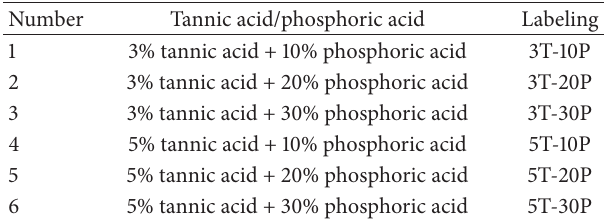
Table 1: The combinations of tannic acid/phosphoric acid (wt%).